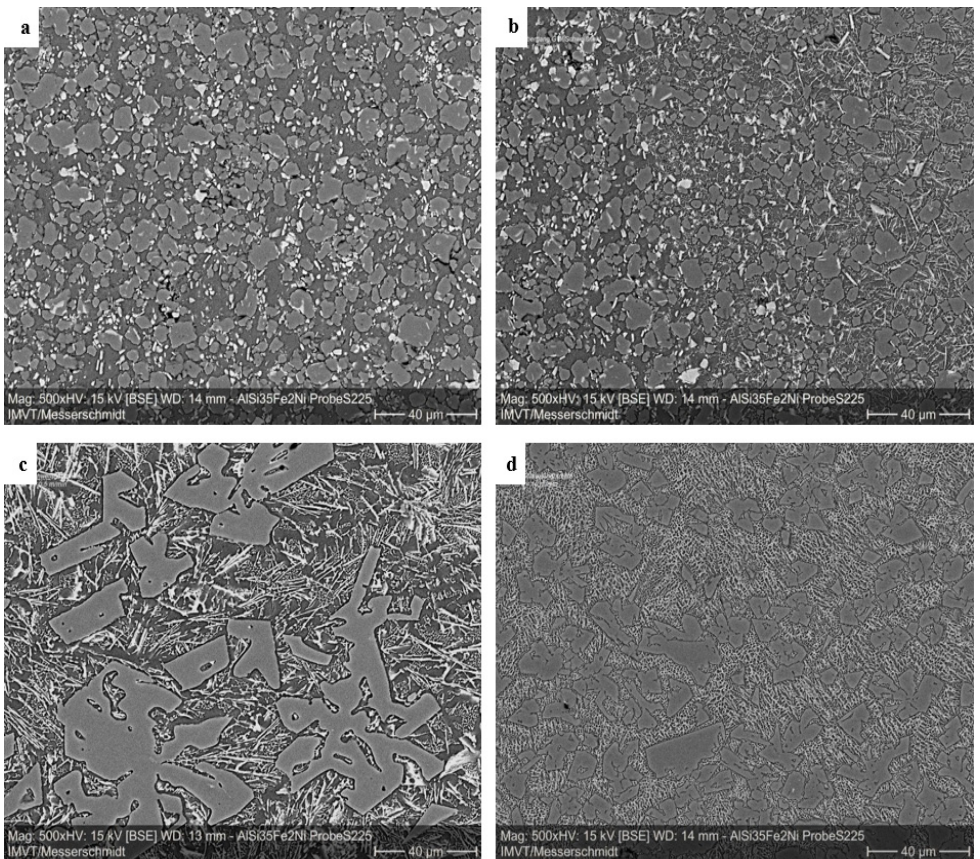
Figure 6. S225. ( a ) Base material; ( b ) Transition of weld seam to base material; ( c ) Center of the weld seam for v = 0.5 m/min; ( d ) Center of the weld seam for v = 10 m/min.